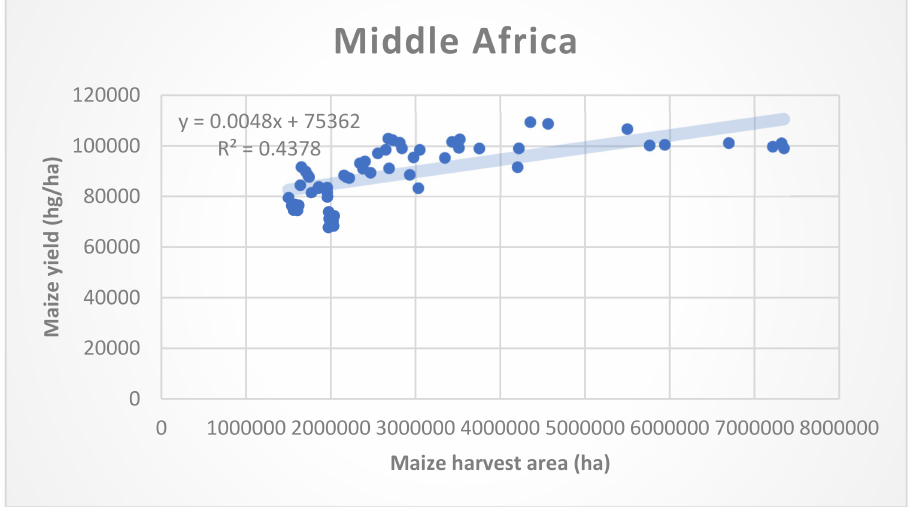
Figure 7. Scatter plot of the relationship between maize yield and harvest area in Middle